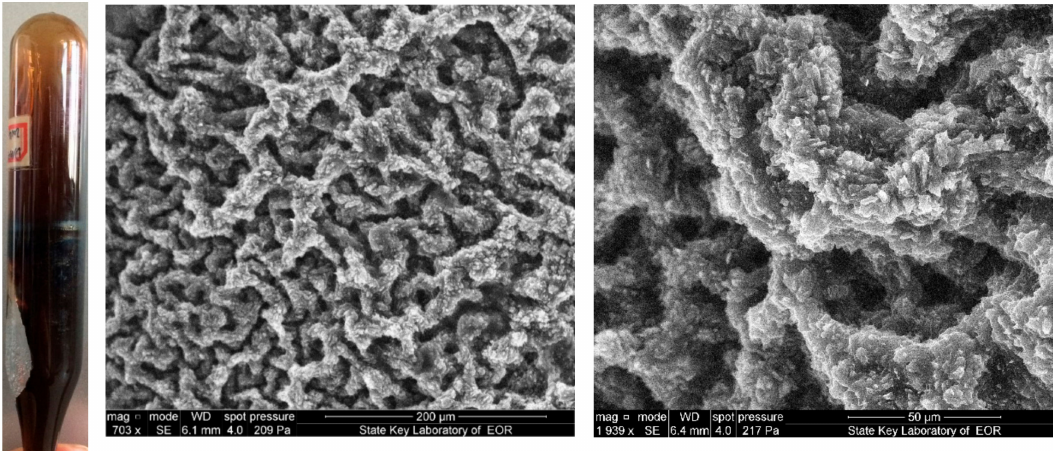
Figure 6. Microstructure of the gel with a gel strength code of